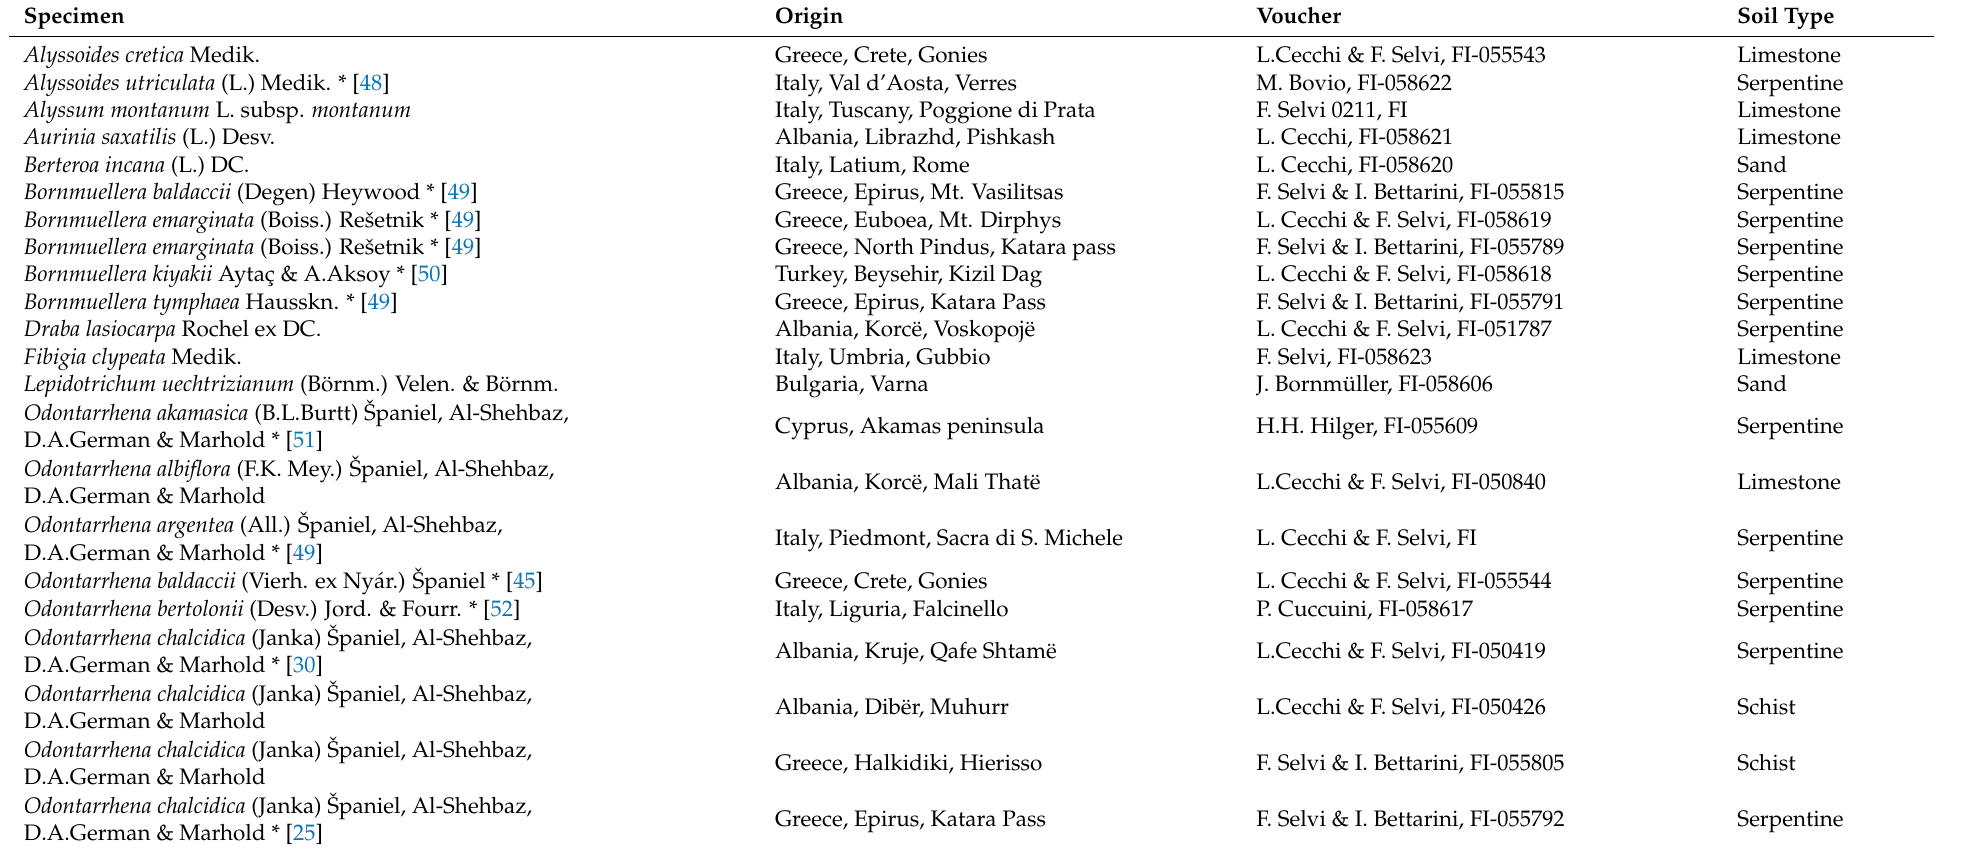
Table A3. List of examined taxa and accessions, with geographic origin, soil type and voucher specimens in FI (Herbarium Centrale Italicum,